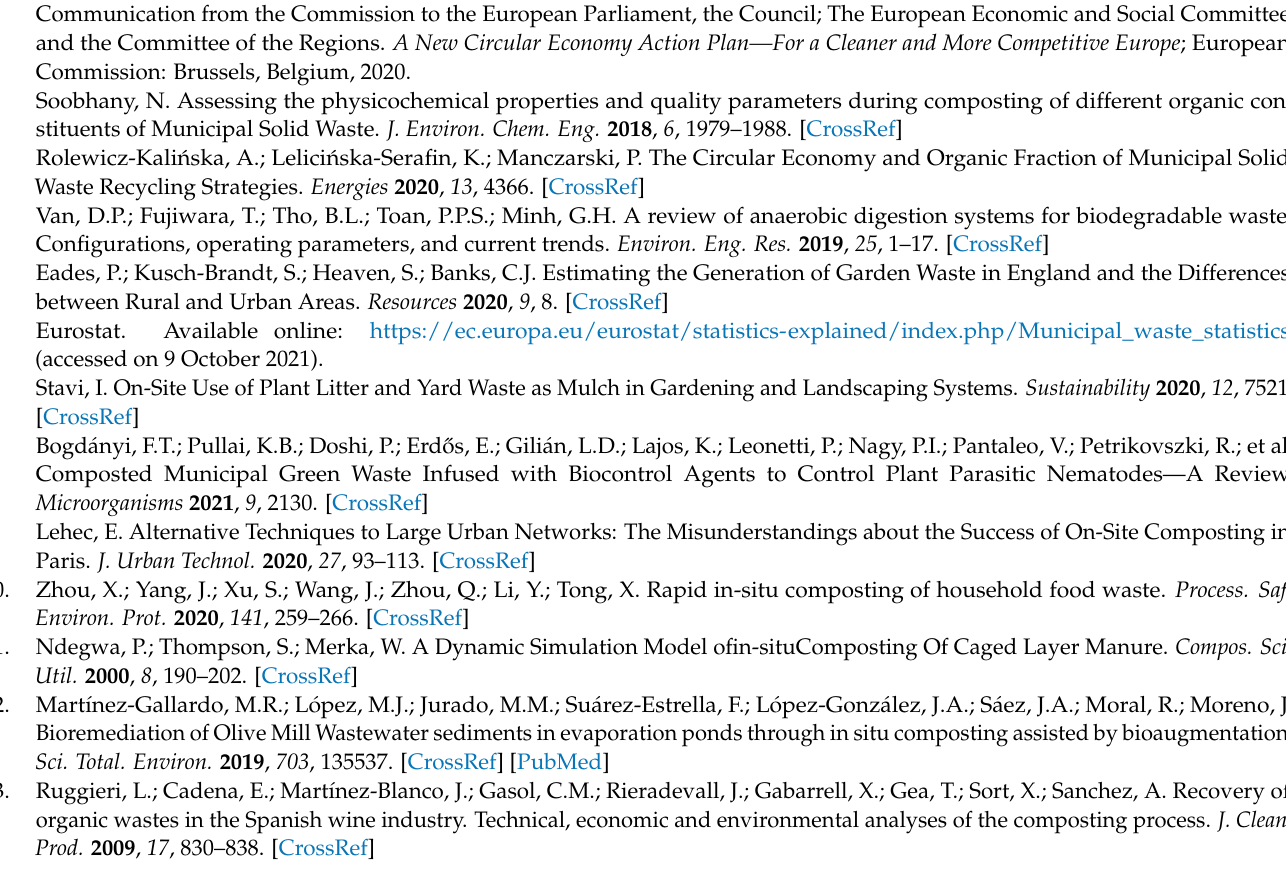
Figure A3. Prionchulus punctatus (Cobb, 1917): a . habitus, b . lip region, c . tail; at 200× magnification: a , at 400× magnification: b , c . Gödöllő, Hungary.